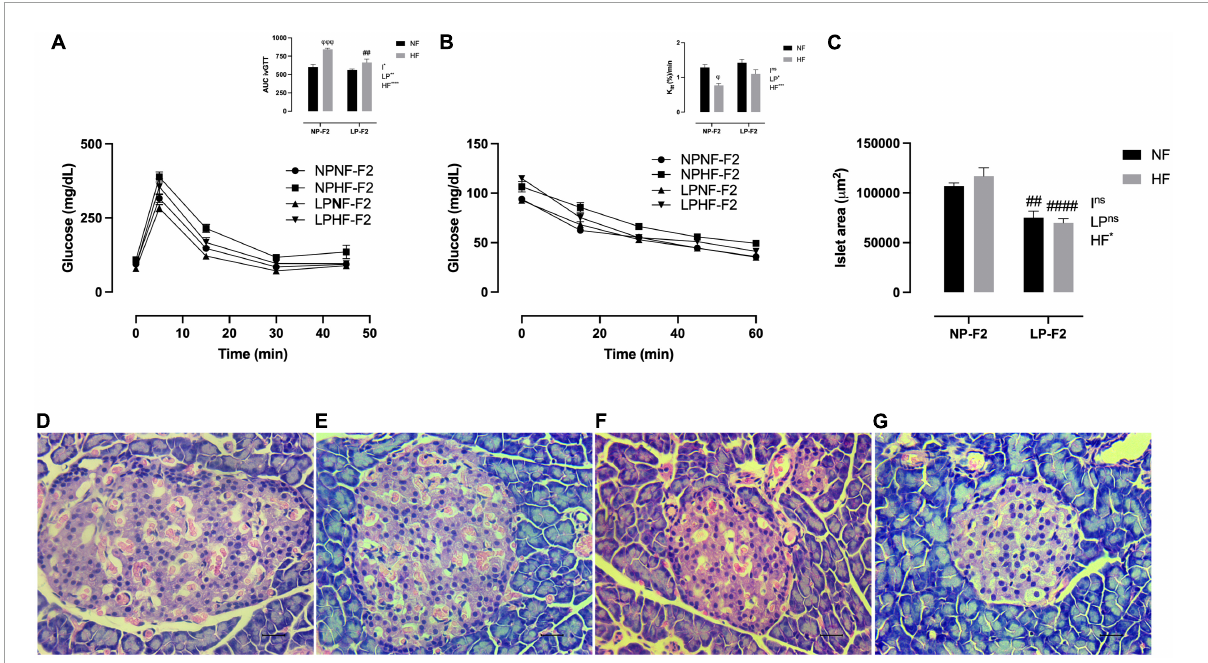
FIGURE4 Glucose homeostasis and pancreas morphometry at 90 days old. Plasma glucose during intravenous glucose tolerance test (ivGTT) (A) , insulin tolerance test and K itt (B) , islet area (C) , NPNF-F2 islet (D) , NPHF-F2 islet (E) , LPNF-F2 islet (F) , and LPHF-F2 islet (G) . The data are expressed as the means ± S.E.M. and were obtained from 6 to 12 rats of each group (from 3 to 6 different litters). ## p < 0.01 and #### p < 0.0001 to NP-F2 vs. LP-F2 in the same conditions; ϕ p < 0.05, ϕϕϕ p < 0.001 to NF vs. HF in the same group for the probability based on Tukey’s post hoc analysis. LP, low-protein diet factor; HF, high-fat diet factor; I, interaction between LP and HF factors. * p < 0.05, ** p < 0.01, *** p < 0.001, **** p < 0.0001, and ns, no significant difference, based on two-way analysis of variance.